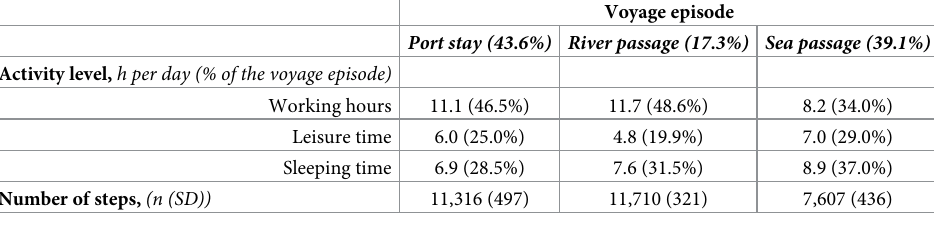
Table 3. Average time (h per day and % of voyage) with different activity levels.